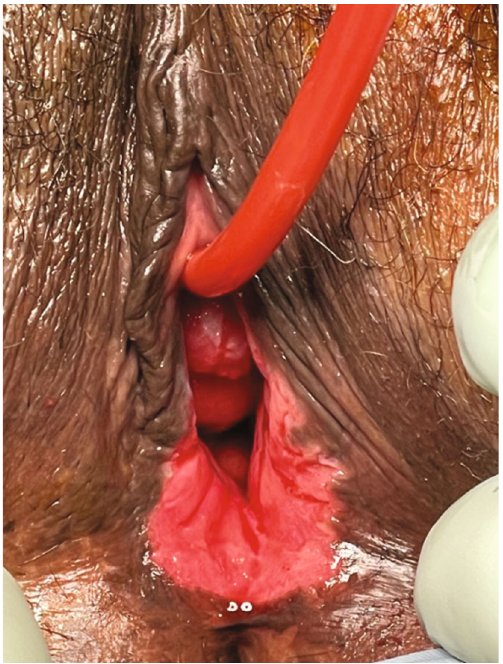
Figure 3: Suspected tumor at the vaginal opening and a suspected tumor covering the urethral